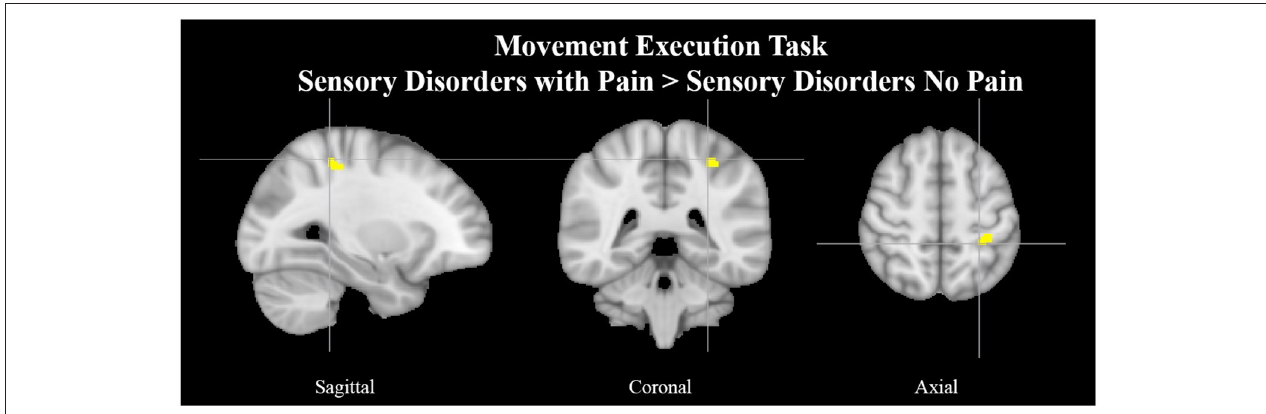
FIGURE 3 | Left superior parietal lobule activation in SAP cohort with pain. Exemplar of a between-group activation peak of the movement execution contrast SAP w/P > SAP NP. Yellow-colored regions show increased brain activity in the left superior parietal lobule (cross- hairs reflect peak activation peak x = − 28, y = − 40, z = 54). SAP, Sensory Altered Processing; w/P, with Pain; NP, No Pain.